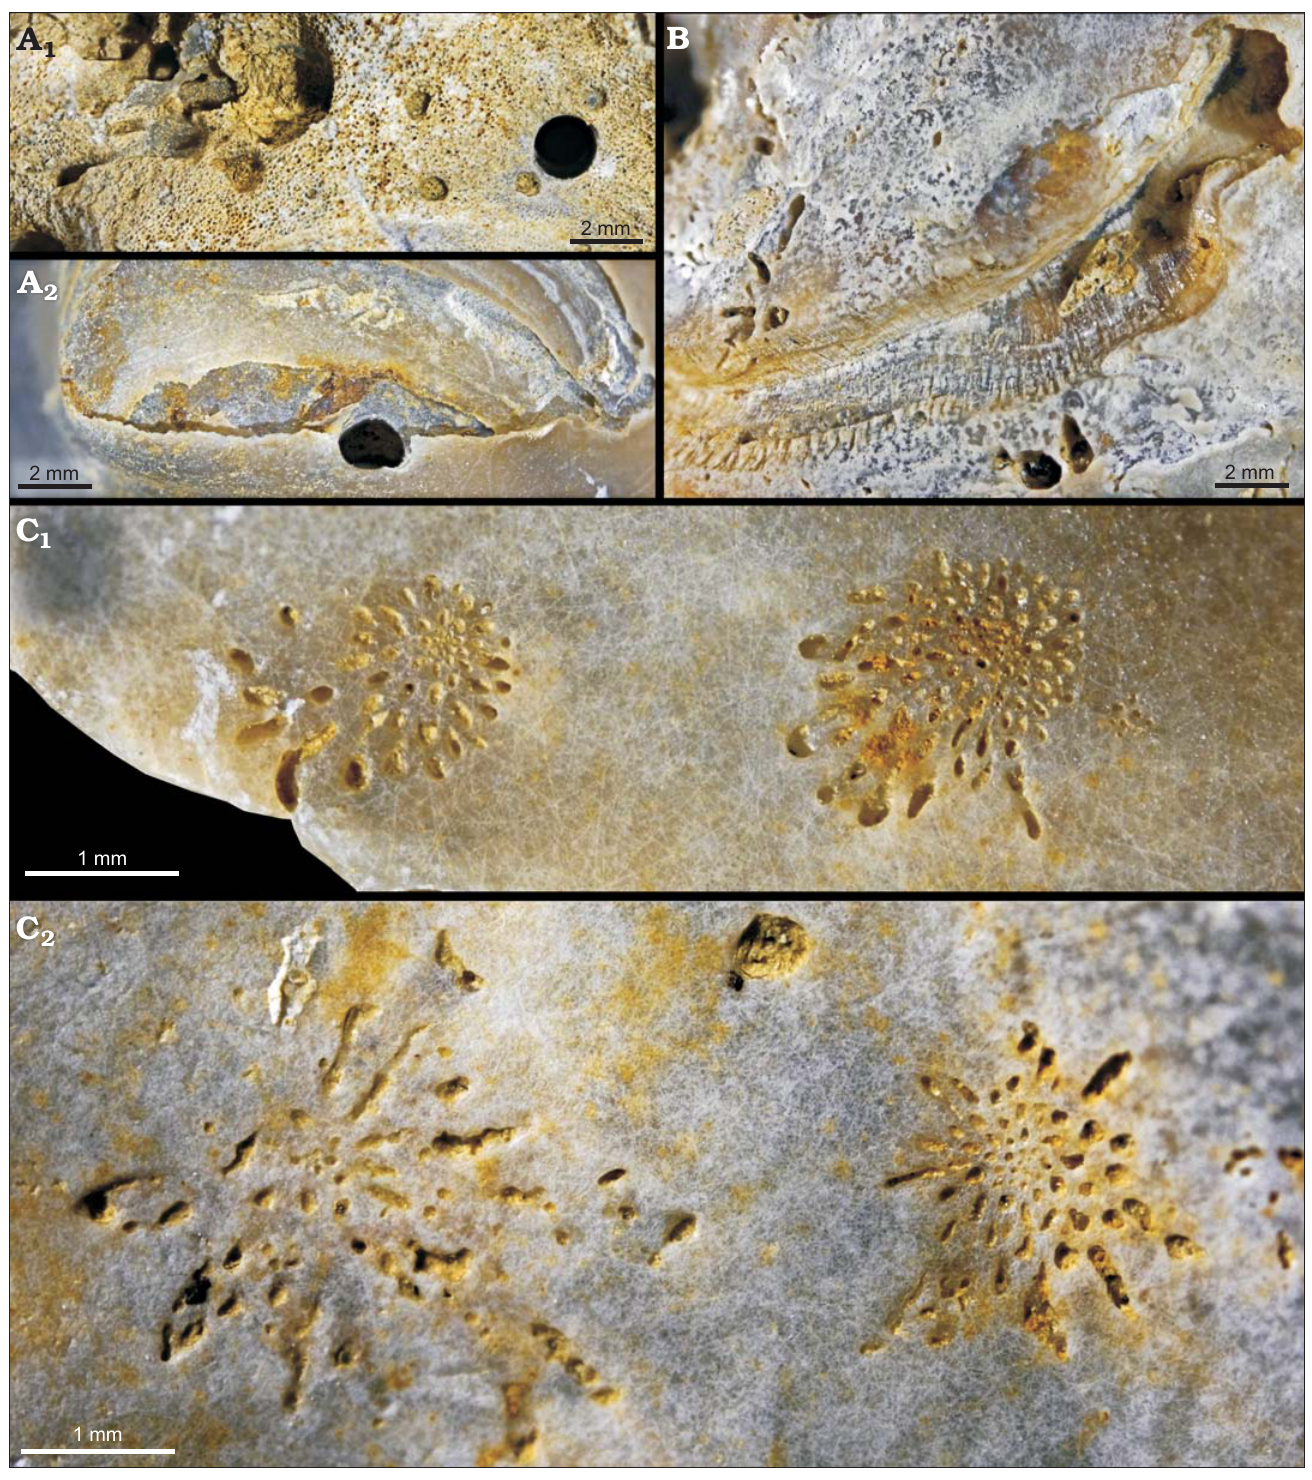
Fig. 4. Traces of borers on oyster Pycnodonte biauriculata (Lamarck, 1819), unless otherwise specified, Marnes à Pycnodonte biauriculata Formation,